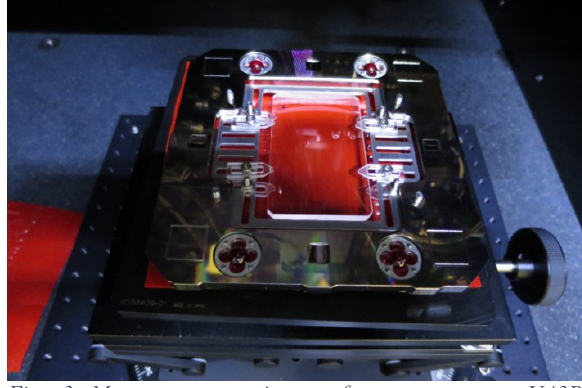
Fig. 3 Measurement equipment for test part on UA3P profilometer.